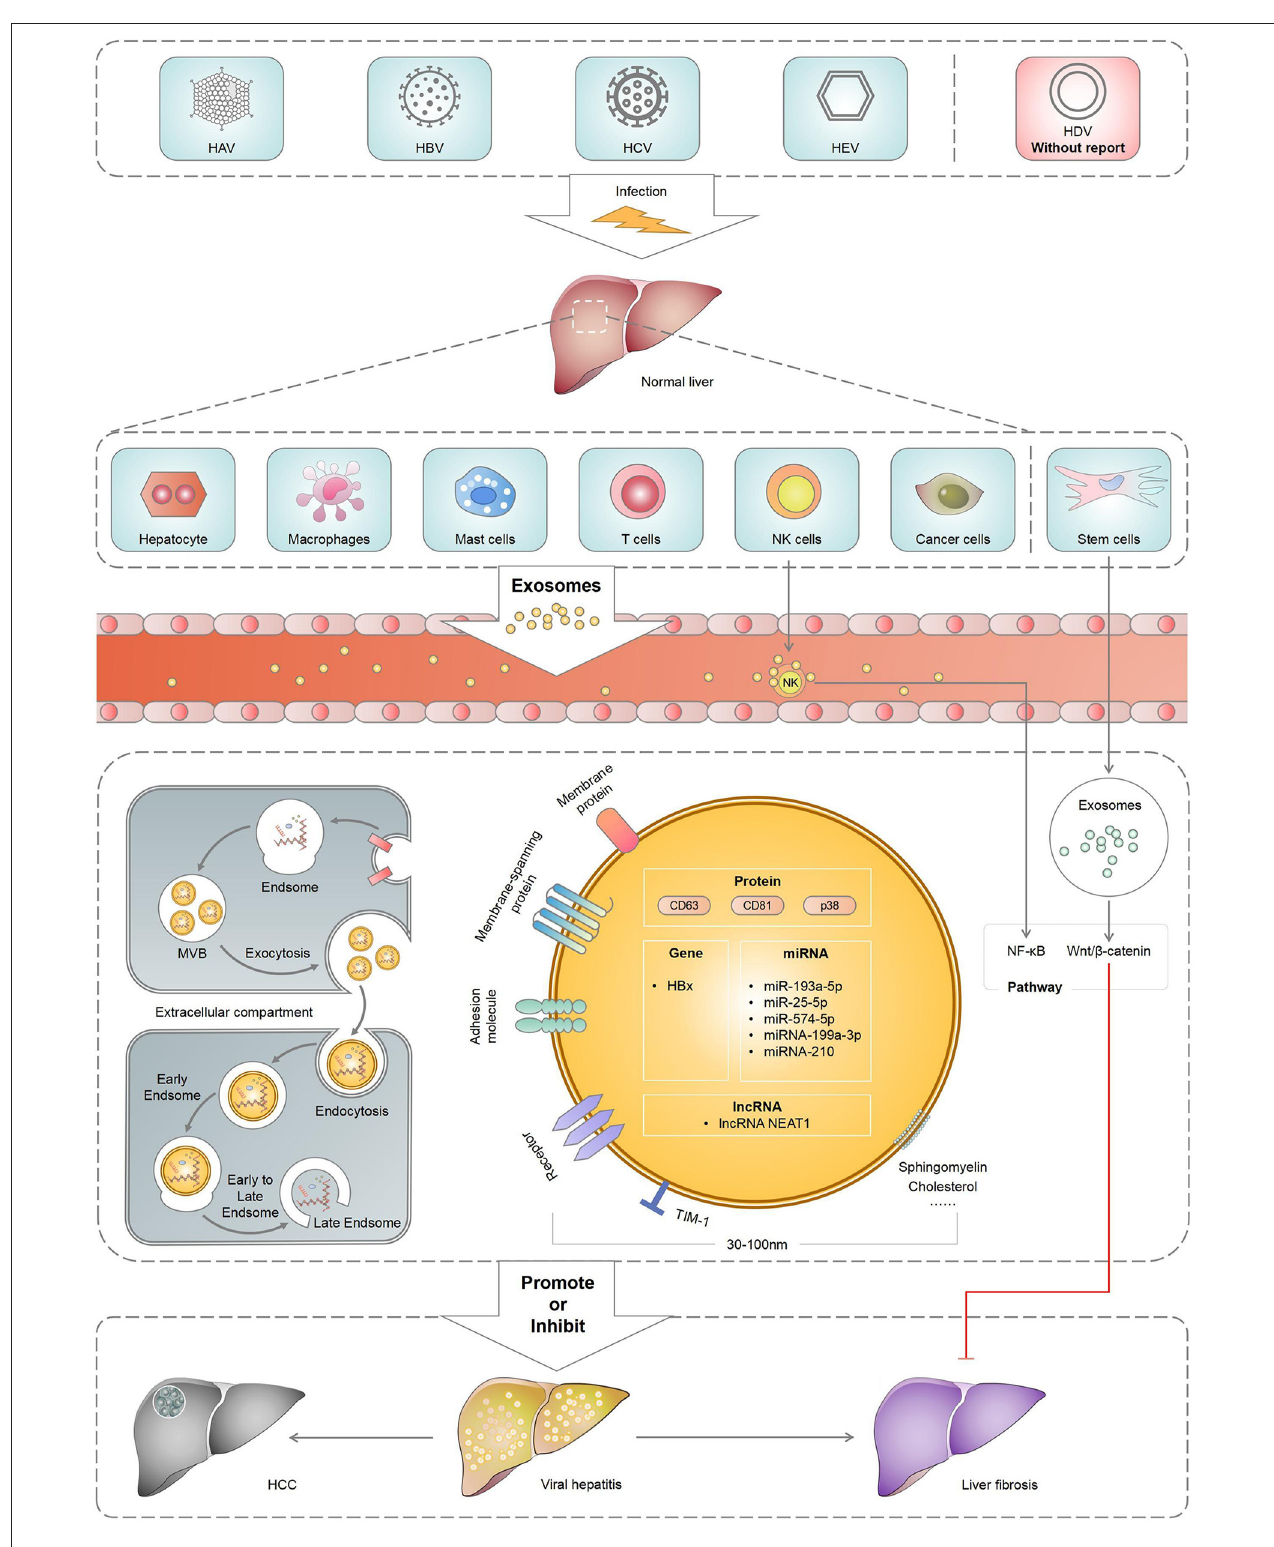
FIGURE 1 | The role of Exosomes in the occurrence, development and metastasis of HCC.